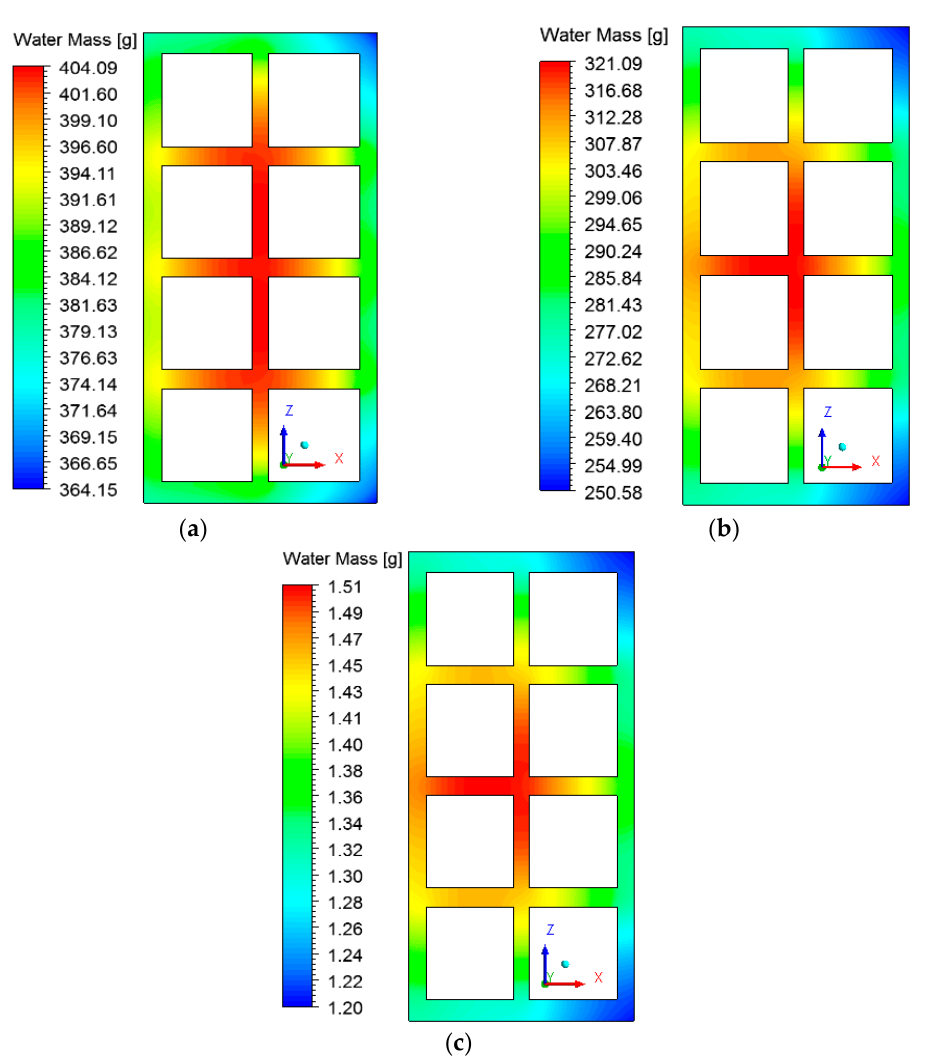
Figure 8. Water mass fields inside the ceramic brick at different moments of drying: ( a ) 10 min, ( b ) 60 min, and ( c ) 950 min.